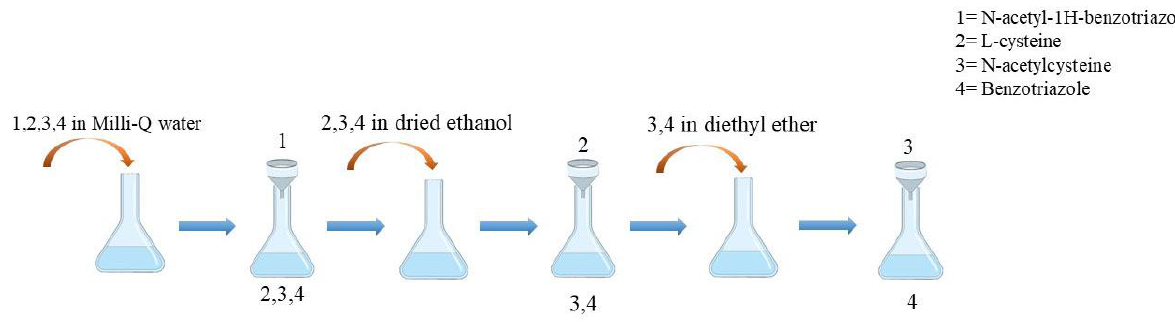
Figure 2. The schematic of three-step isolation process of N -acetylcysteine.